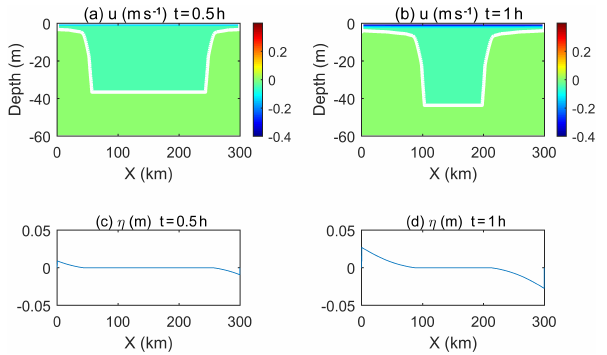
Figure 2. Snapshots of eastward velocity and elevation ( η) at t = 0.5 and 1h. The white lines represent the value of zero.